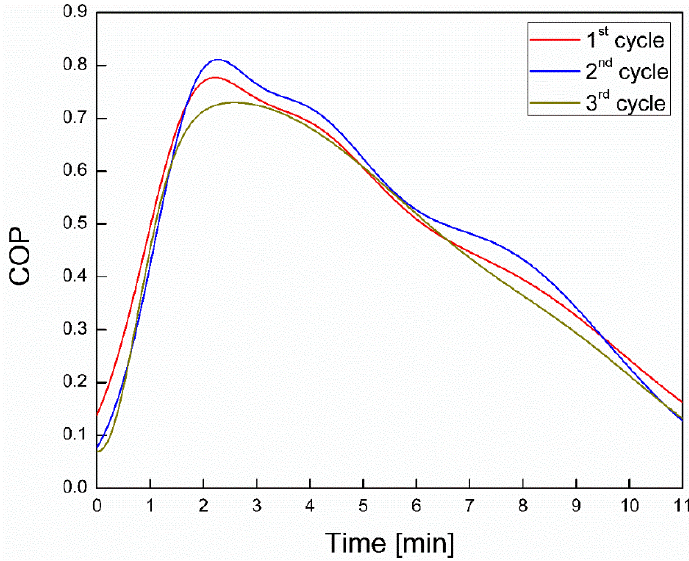
Figure 10. Variation of coefficient of performance during the cycle period.